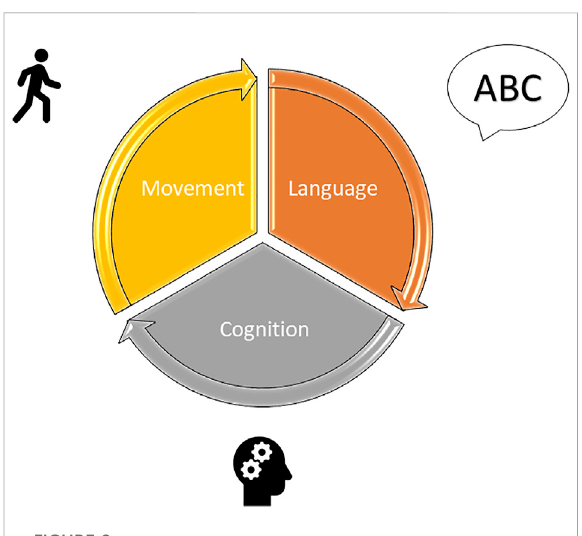
FIGURE 2 Rehabilitation of pediatric patients with CMS must consider the three main impaired domains, namely speech, cognition/ behavior, and